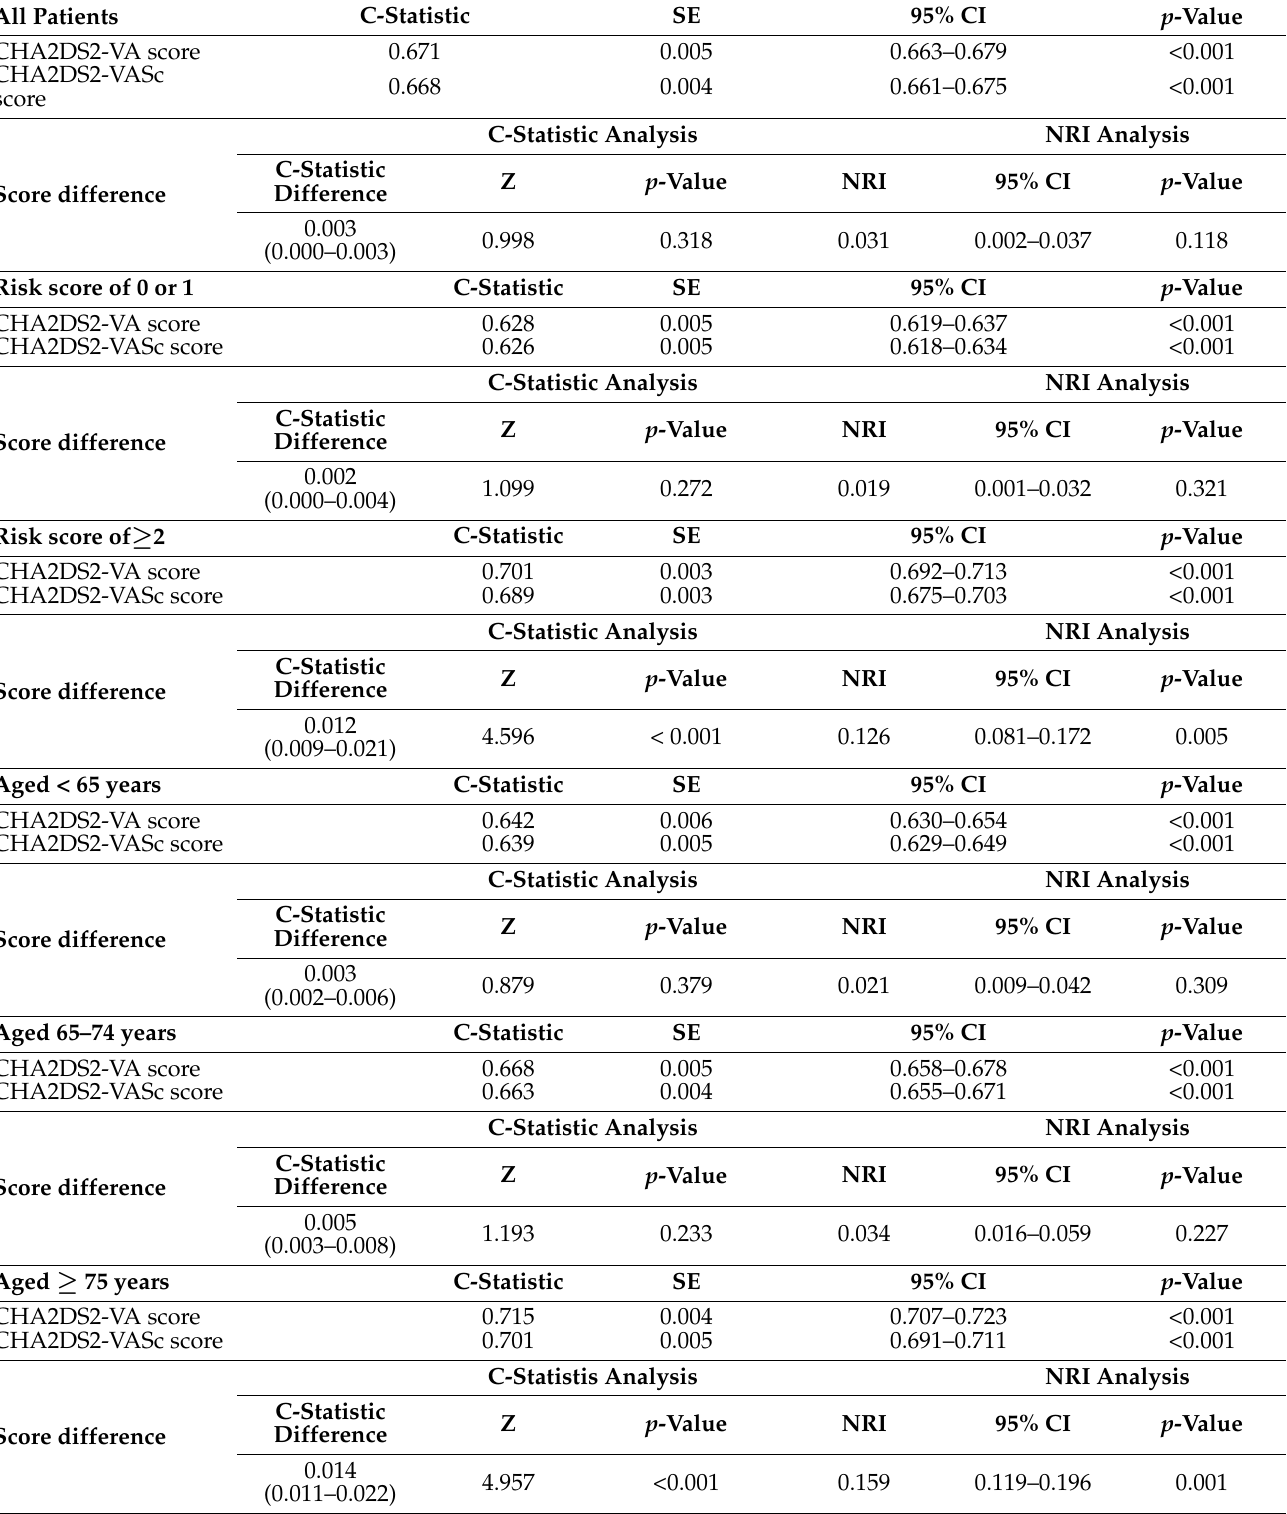
Table 4. Comparison of the scores for ischemic stroke predictions in AF patients stratified by risk scores and age